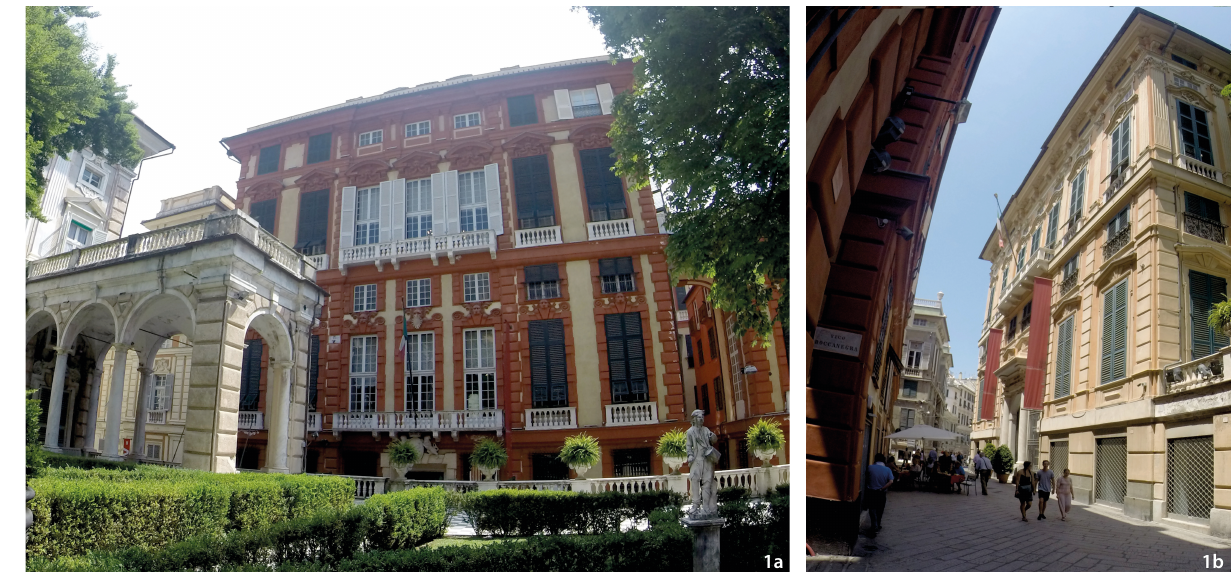
Figure 1a The Rolli Palaces, Palazzo Bianco (Source: the author). Figure 1b The Rolli Palaces, Palazzo Rosso (Source: the